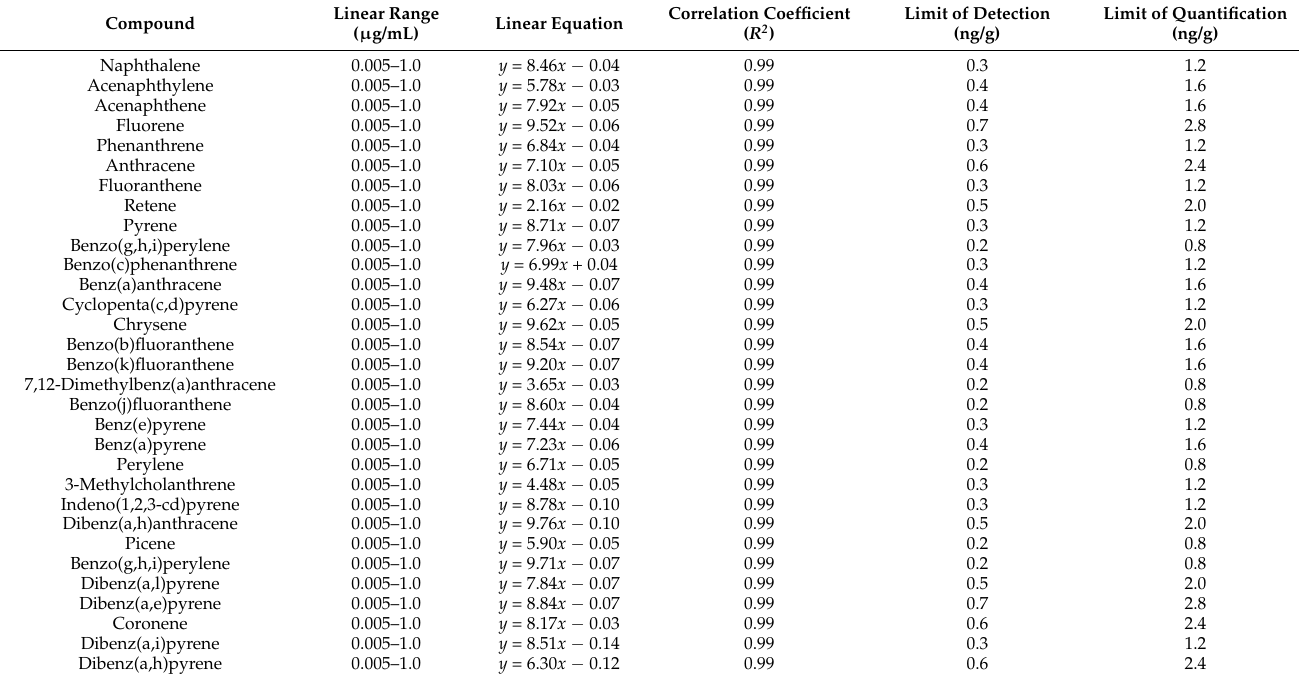
Table 2. Linear ranges, linear equations, correlation coefficients, limits of detection limit, and limits of quantification of